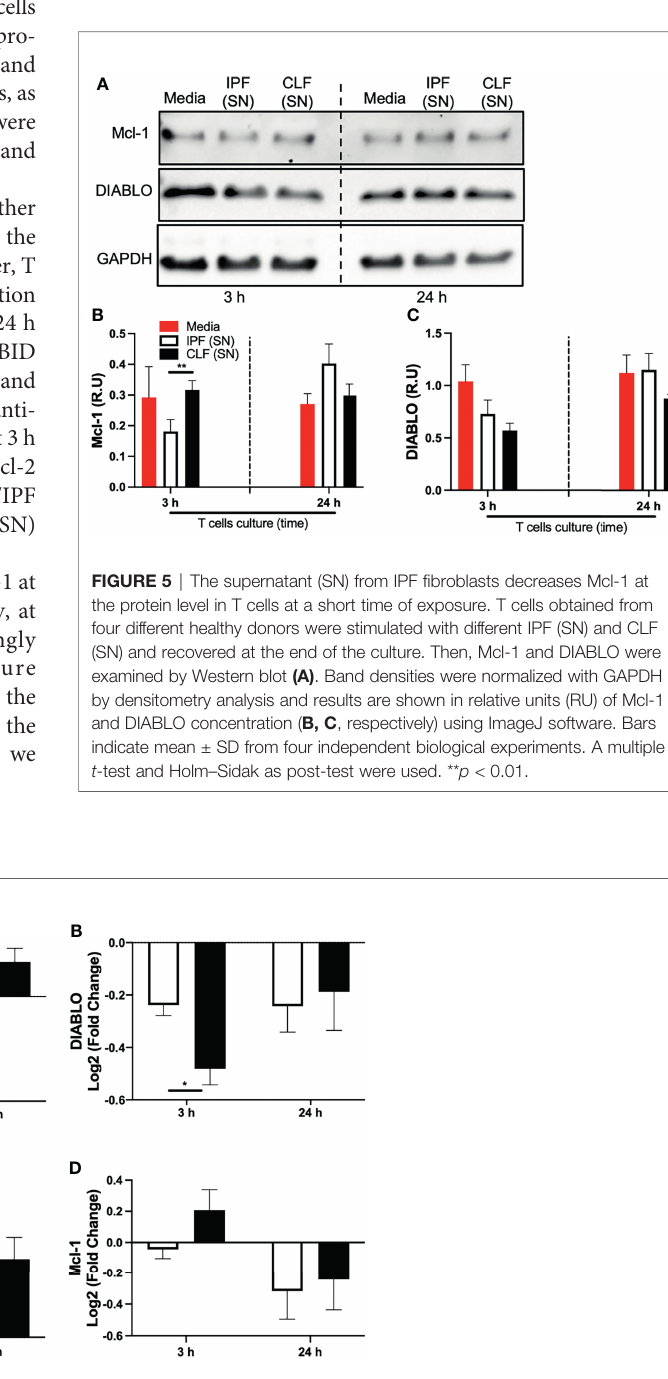
FIGURE 4 | The supernatant (SN) from IPF fi broblasts affects the Bcl-2 anti-apoptotic pro fi le of T cells at a short time of exposure. T cells from fi ve different healthy controls were stimulated with different IPF (SN) and CLF (SN), recovered at the end of 3 and 24 h of culture, and RNA was extracted for quantitative real-time PCR. We calculated the log2 fold change of the expression of BID (A) , DIABLO (B) , Bcl-2 (C) , and Mcl-1 (D) . Bars indicate mean ± SD from fi ve independent biological experiments. A Mann – Whitney U test was used. * p < 0.05.